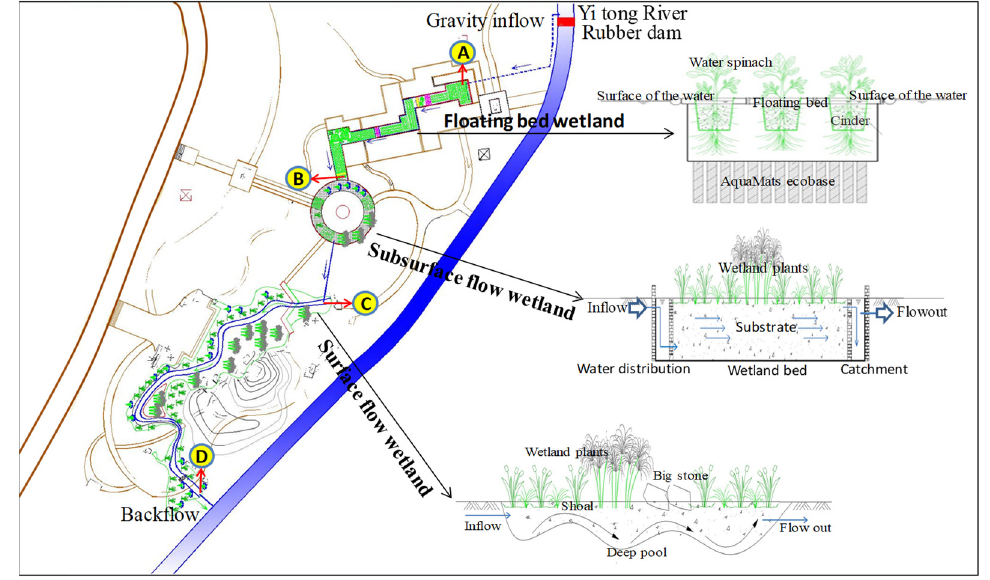
Figure 2. Processing flow and configuration.